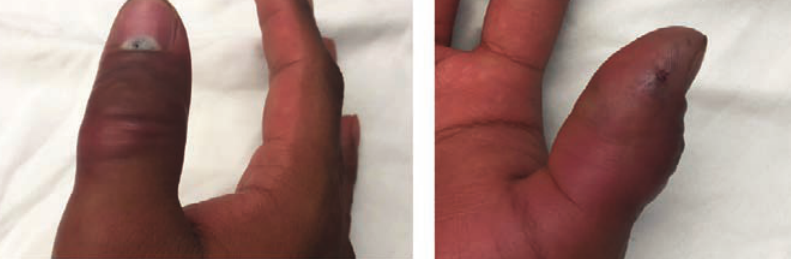
Figure 1. Images of the right thumb on initial presentation with a puncture injury extending obliquely through the proximal nail plate and radial margin of the pulp.